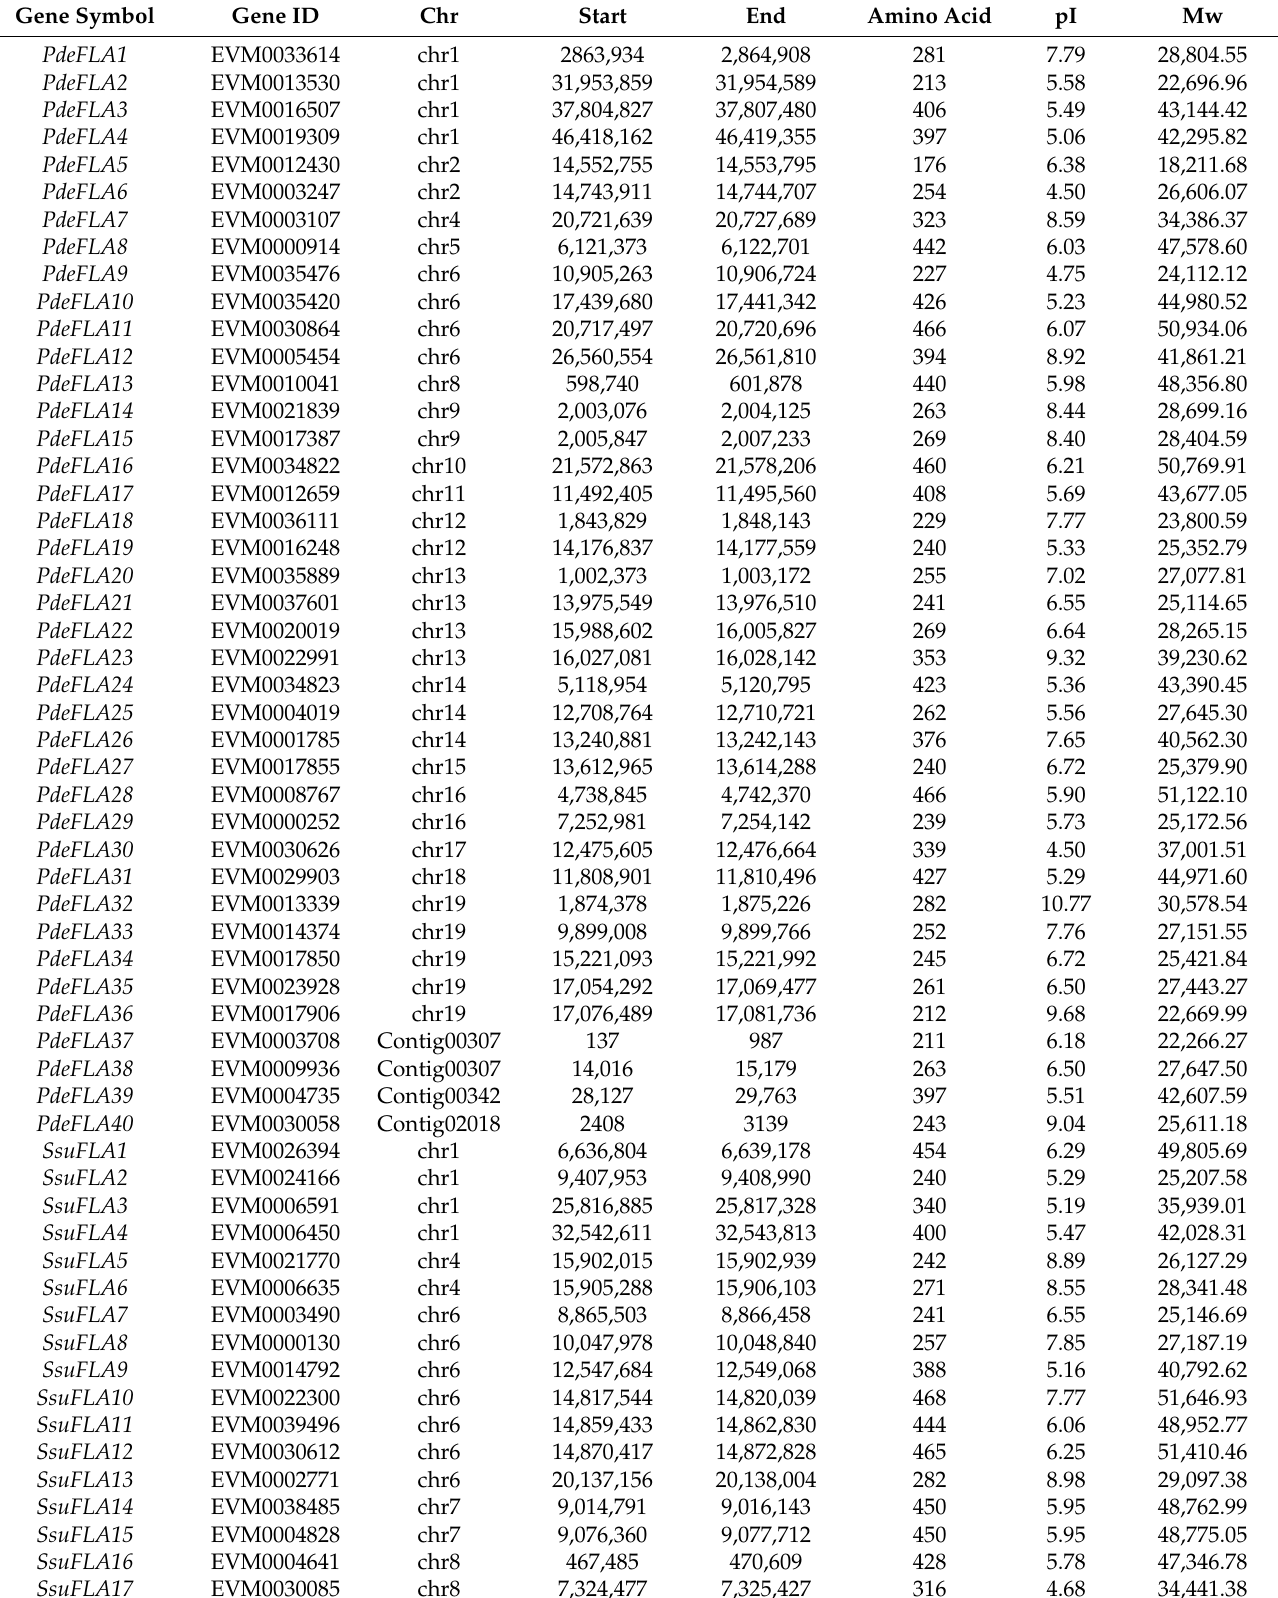
Table 1. Putative FLA genes identified in the genomes of P. deltoides and S. suchowensis